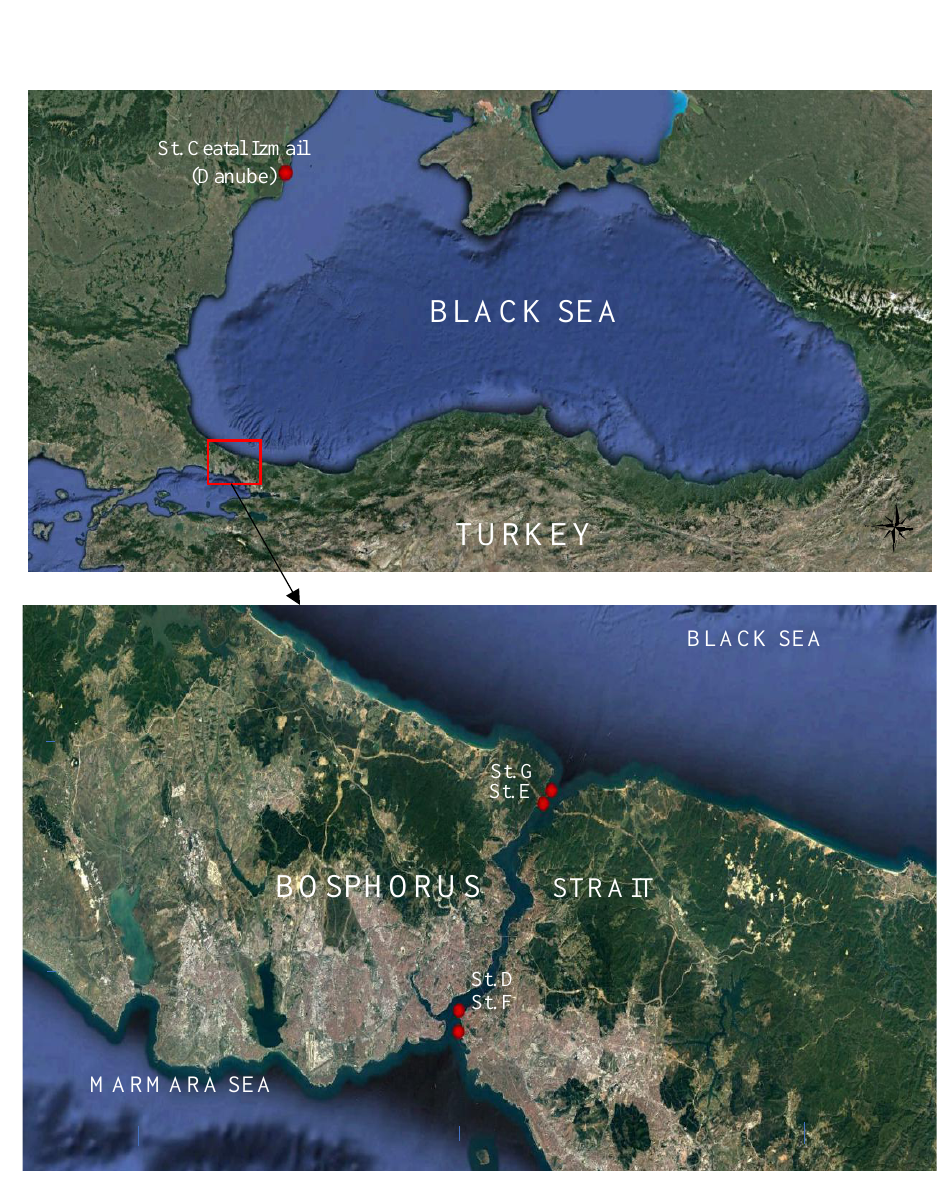
Figure 1. The aerial view of the Bosphorus Strait and the locations of the measurement stations in Bosphorus